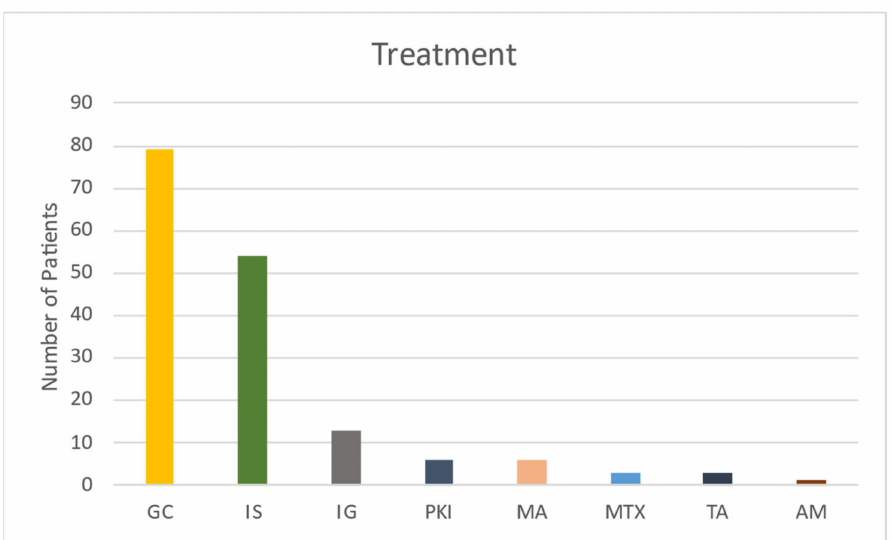
Figure 5. The table shows the distribution of medical treatment done in patients with chronic muscu- loskeletal GVHD. Abbreviation: GC, Glucocorticoids; IS, Immunosuppressant; IG, Immunoglobulins; PKI, Protein Kinase Inhibitor; MA, Monoclonal Antibodies; MTX, Methotrexate; TA, Therapeutic Apharesis; AM, Antimalarial. Designation: Glucocorticoids, Prednisolon, Methylprednisolon, and Budenoside; Immunosuppressant, Ciclosporin, Tacrolimus, Azathioprine, Mycophenolate Mofetil, Leflunimid, and Cyclophosphamide; Immunoglobulins, Polyvalent Immunoglobulins, and Gamma globulin; Protein Kinase Inhibitor, Ruxolitinib, and Ibrutinib; Monoclonal Antibodies, and Rituximab; MTX, Methotrexate; and Therapeutic apharesis, Plasmaexchange, and Extracorpeoral